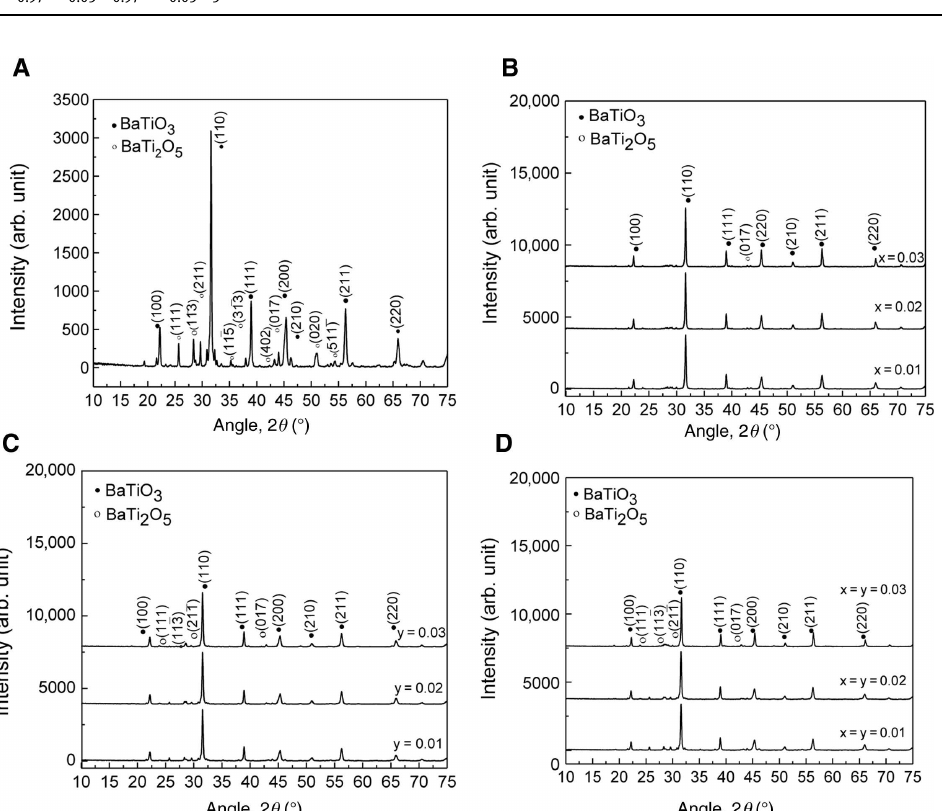
Figure 2: XRD pattern for the (A) pure, (B) Ce doped, (C) Mn doped, and (D) Ce-Mn-co-doped BaTiO 3 , where the filled and unfilled circle represents the BaTiO 3 and BaTi 2 O 5 phase,